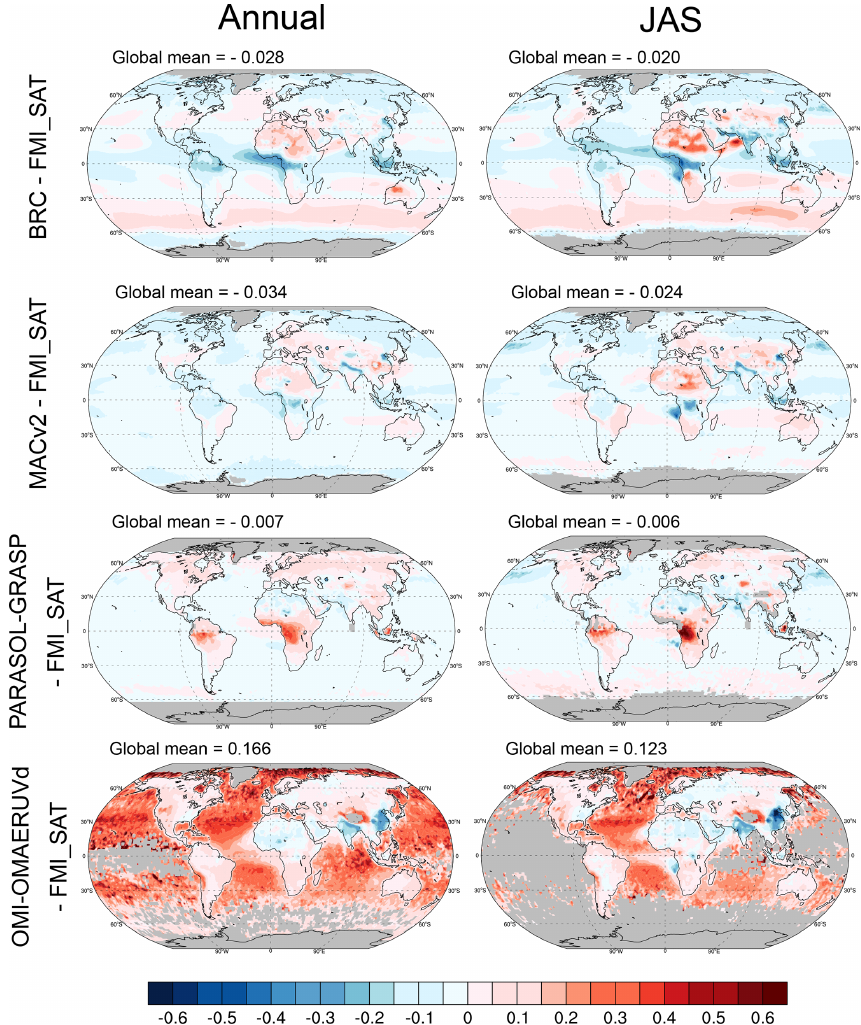
Figure A6. AOD (550nm; see Tables 2 and 3 for details) difference between FMI_SAT and the BRC simulation, MACv2, PARASOL- GRASP, and OMI-OMAERUVd averaged over the year and over JAS. Shaded areas indicate a missing